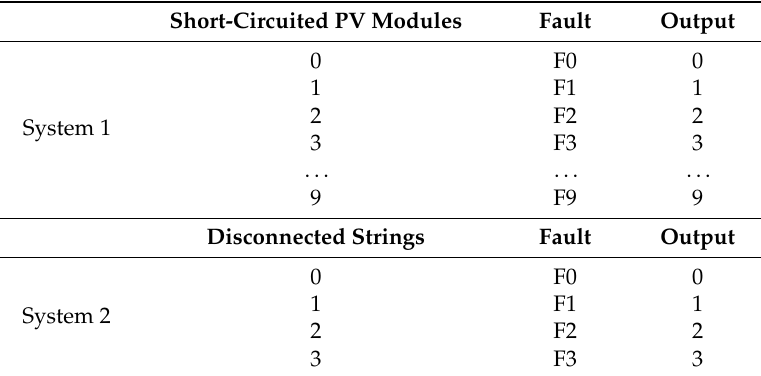
Table 5. Faults indicated by the detection method.